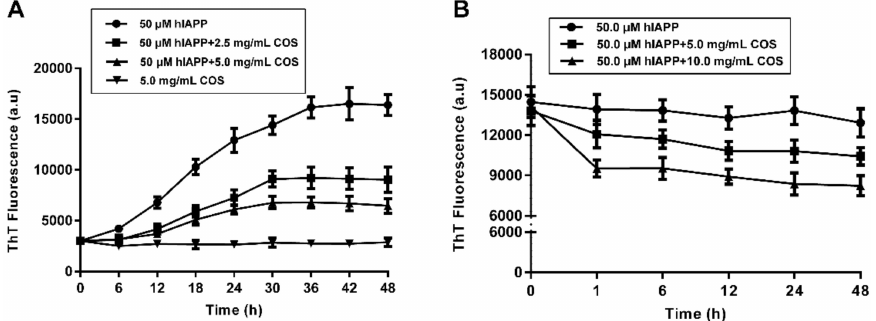
Figure 2. Thioflavin T (ThT) fluorescence analysis of chitosan oligosaccharides (COS) on human islet amyloid polypeptide (hIAPP) amyloid formation and disaggregation. ( A ) E ff ects of COS on hIAPP amyloid formation. ( B ) E ff ects of COS on the preformed hIAPP amyloid